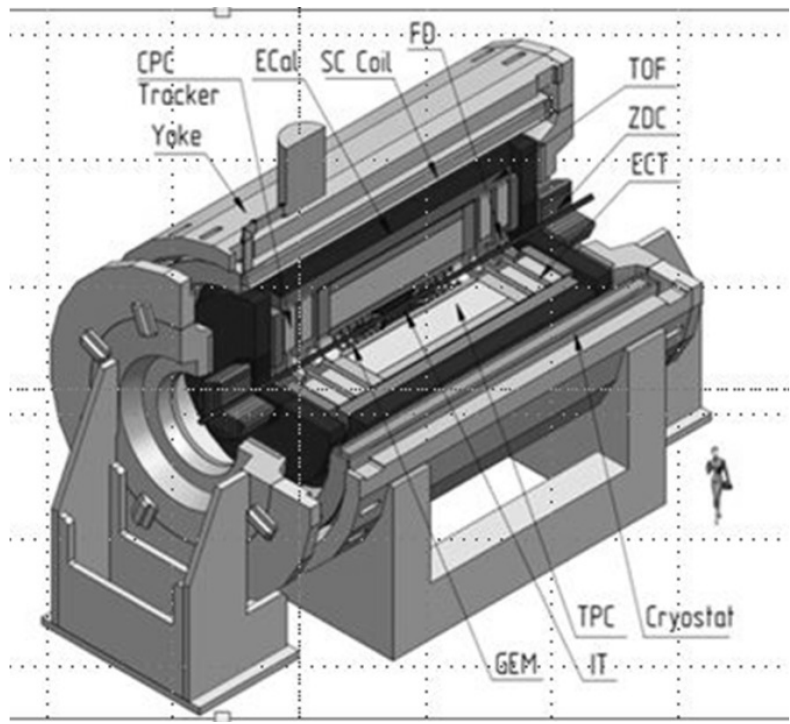
Figure 2. General view of the Multi Purpose Detector (MPD), with the denotation of the main subsys- tems of ther detector